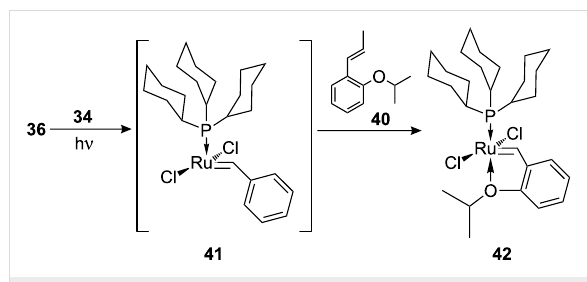
Scheme 9: Trapping of proposed intermediate 41 .